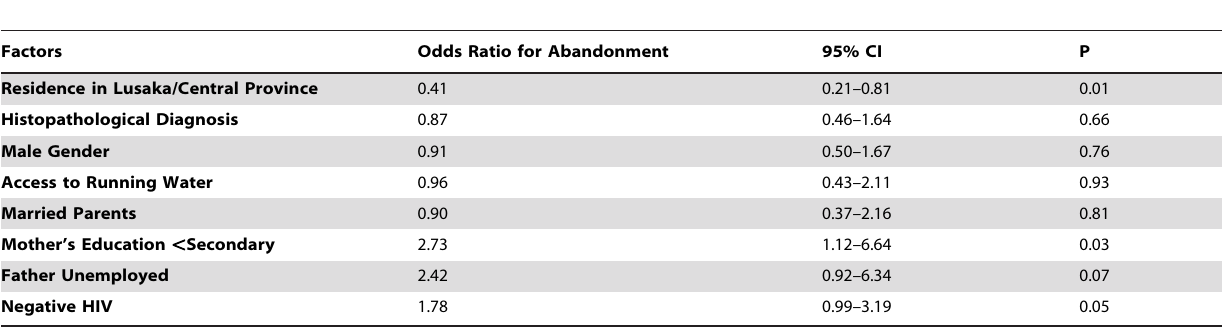
Table 2. Factors Associated with Abandonment of Treatment (Unadjusted Analysis). Residence, HIV status and maternal education used in model.